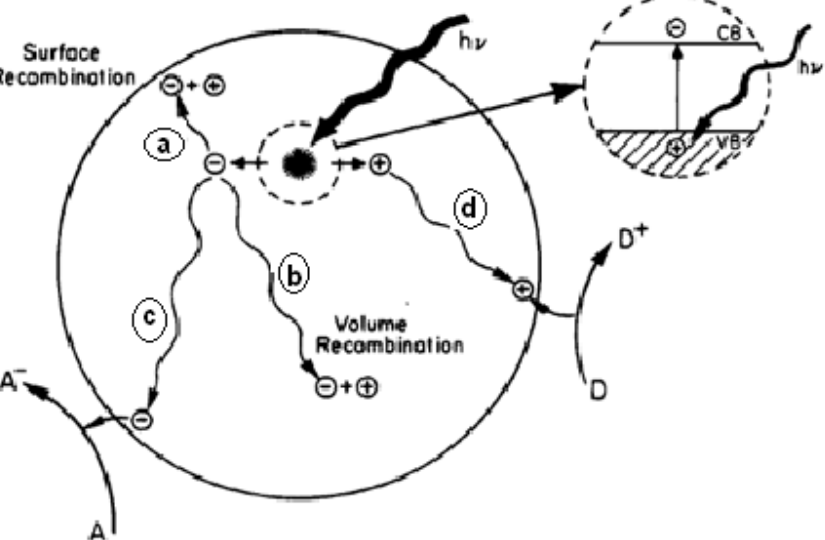
Figure 9. The schematic of photoexcitation followed by de-excitation on the semiconductor’s sur- face [160].